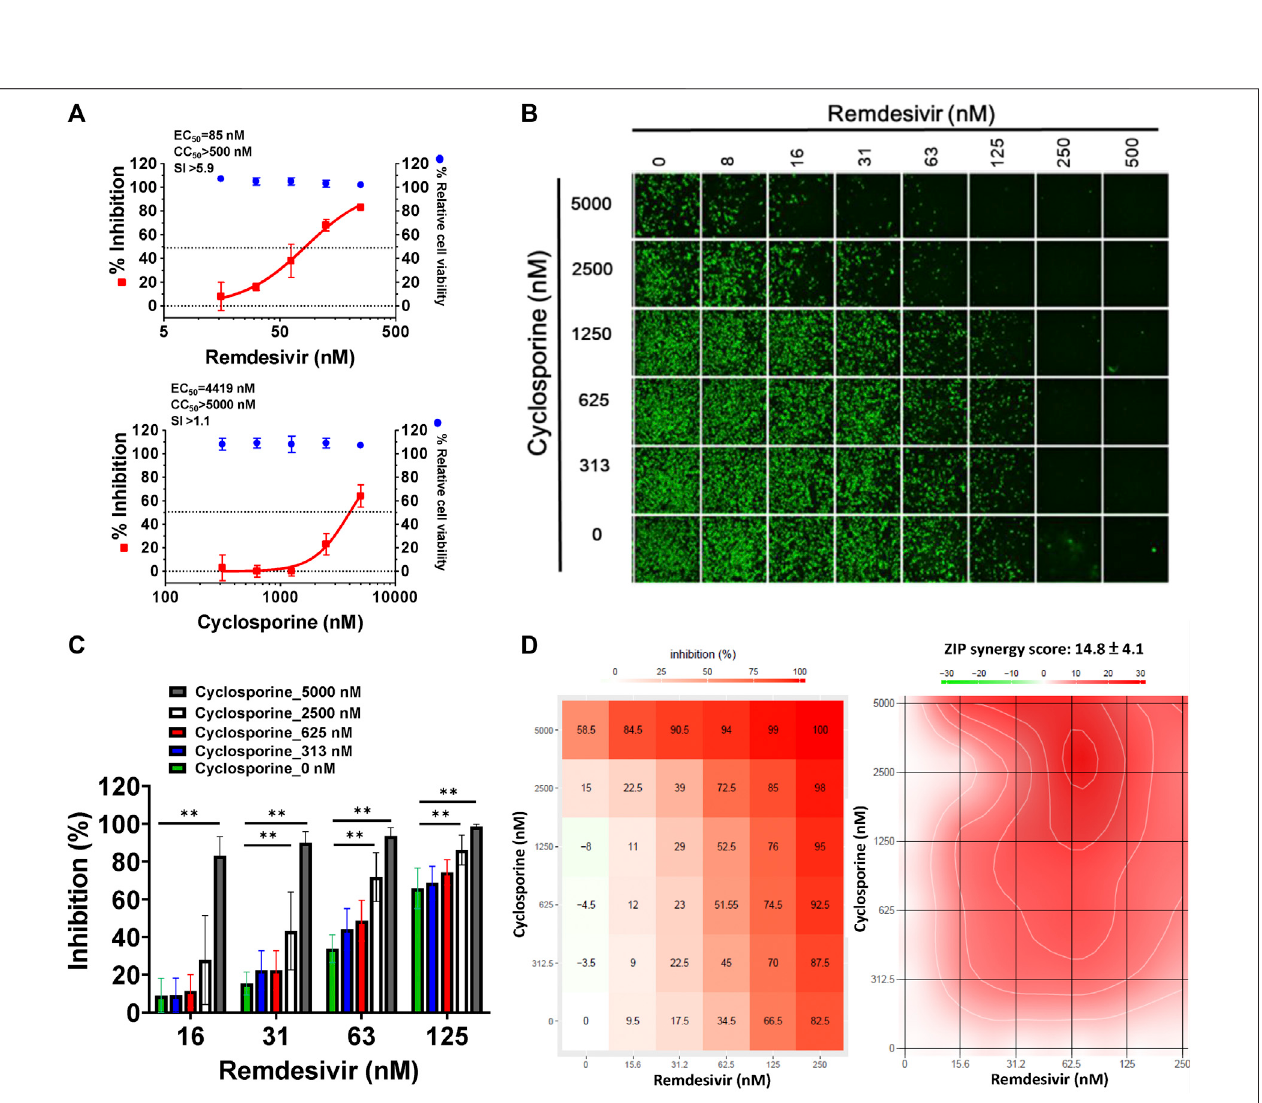
FIGURE 2 | Single or combined treatments of remdesivir and cyclosporine profoundly reduced HCoV-OC43 infection in human fetal lung fi broblast MRC-5 cells assayed by IFA. (A) Single treatments of remdesivir and cyclosporine reduced HCoV-OC43 infection in MRC-5 cells in a dose dependent manner. (B – D) Combined treatments of remdesivir and cyclosporine synergistically reduced the HCoV-OC43 infection in MRC-5 cells. IFAs were performed with an antibody against N protein (green) of HCoV-OC43 in HCoV-OC43 (0.05 MOI) infected MRC-5 cells at 30 h.p.i. treated with vehicle (0.5% DMSO) or compounds as indicated. Nuclei (blue) werecounter stainedwithHoechst dye andused todetermine therelative cellviabilitybyusingthenumber ofnucleiinvehicle controlas100%( Supplementary Figure S2 ).The fl uorescentsignalofIFAwasnormalizedwithcellviabilitytocalculatetheinfectionratethatnocompoundtreatmentwassetat100%.MRC-5cellswereseeded the day before compound treatment or HCoV-OC43 infection. Tested compounds were added to the wells 1 h prior to the addition of HCoV-OC43 at an MOI of 0.05. The resulting cultures were then incubated for an additional 30 h at 37 ° C. AVE ± SD of three independent experiments are shown (A and C) . The statistical signi fi cance was evaluated using one-way ANOVA followed by Tukey ’ s multiple comparison test. * and ** denote statistical signi fi cance of p < 0.05, and p < 0.01 respectively. IFA images shown are representative of three independent experiments (B) . Shown inhibition % (AVE) and synergy scores (AVE ± SD) are from three independent experiments (D) analyzed via SynergyFinder (https://synergy fi nder. fi mm. fi /).